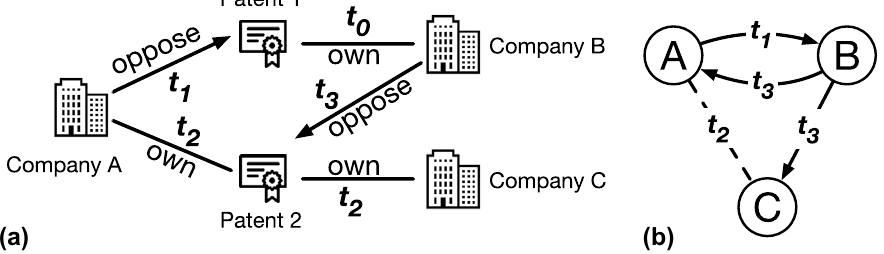
Figure 1. ( a ) An example for patent oppositions and collaborations. Company A opposes a patent owned by company B at t 1 , and then companies A and C co-own a patent at t 2 , which is opposed by company B at t 3 . ( b ) The corresponding patent network. The directed solid lines represent patent oppositions. The undirected dashed line represents the